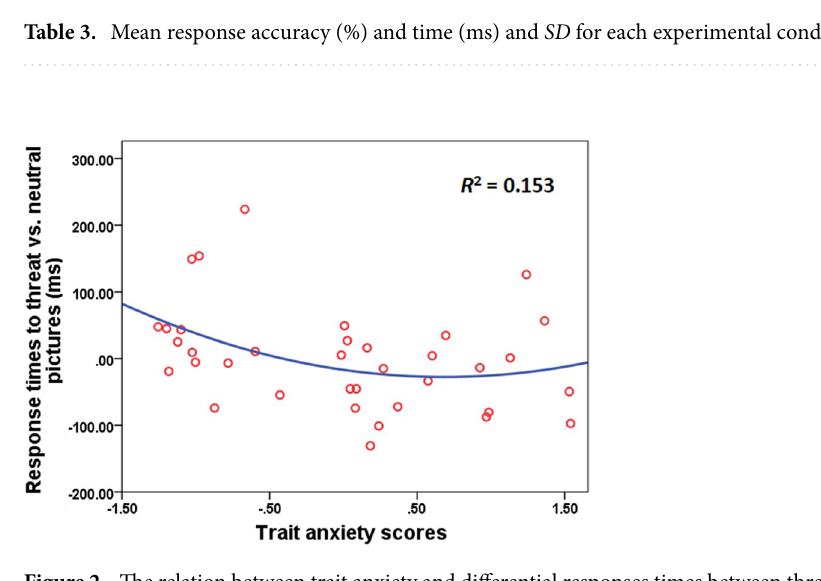
Figure 2. The relation between trait anxiety and differential responses times between threat and neutral pictures in the explicit condition. The fittest model was the quadratic